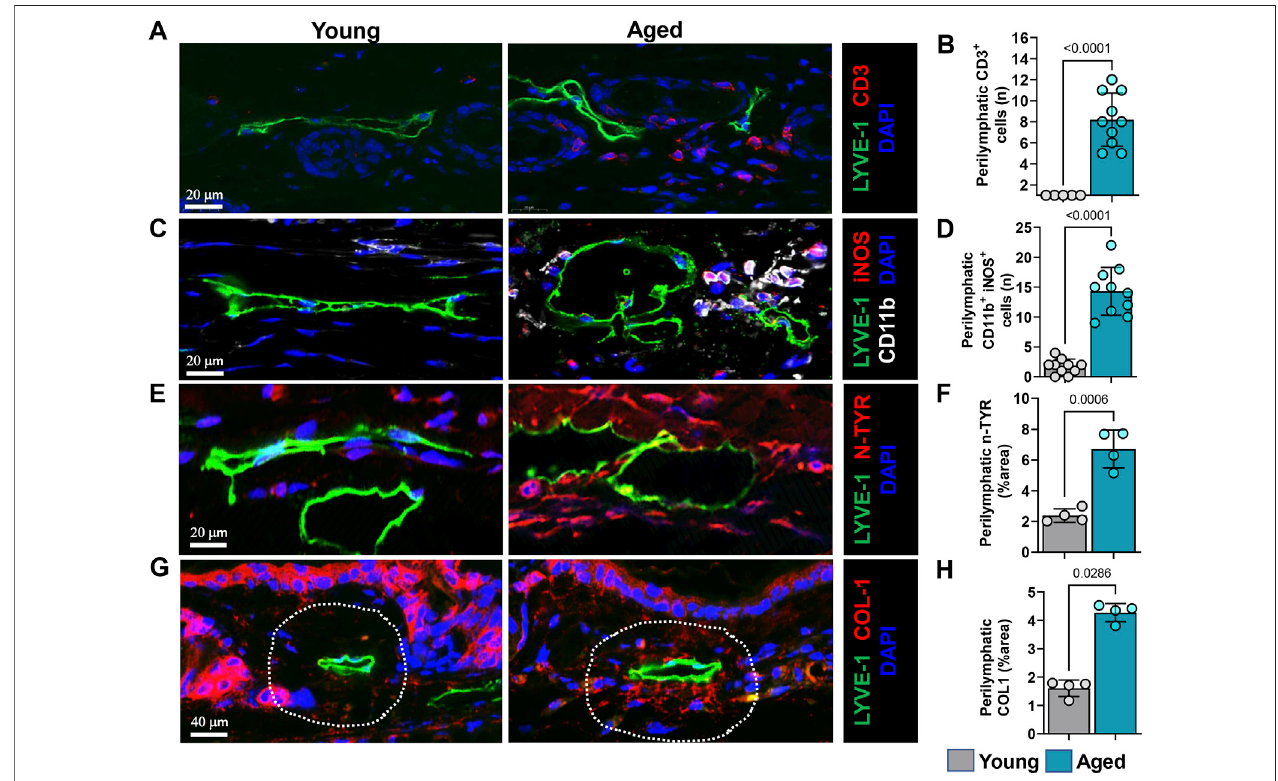
FIGURE 5 | Aging causes increased immune cell in fi ltration and nitrosative stress surrounding lymphatics. (A) Representative confocal images of ear skin sections stainedforlymphaticvessels(LYVE-1)andTcells(CD3). (B) Quanti fi cationofTcellswithin100 µmradiusoflymphaticvessels. (C) Representativeconfocalimagesofear skinsectionsstainedforlymphaticvessels(LYVE-1)andmyeloidcells(CD11b+/iNOS+). (D) Quanti fi cationofmyeloidcellswithin100 µmradiusoflymphaticvessels. (E) Representative confocal images of ear skin sections stained for lymphatic vessels (LYVE-1) and nitrotyrosine (N-Tyr), a marker of nitrosative stress. (F) Quanti fi cation ofN-Tyrpositivitywithin100 µm radius oflymphatic vessels. (G) Representativeconfocal imagesofearskin sections stainedforlymphaticvessels (LYVE- 1) and collagen-1. (H) Quanti fi cation of collagen-1 deposits within 100 µm radius of lymphatic vessels. n = 5 mice per group in all experiments. All quanti fi cations are mean ± SD, unpaired Student ’ s t